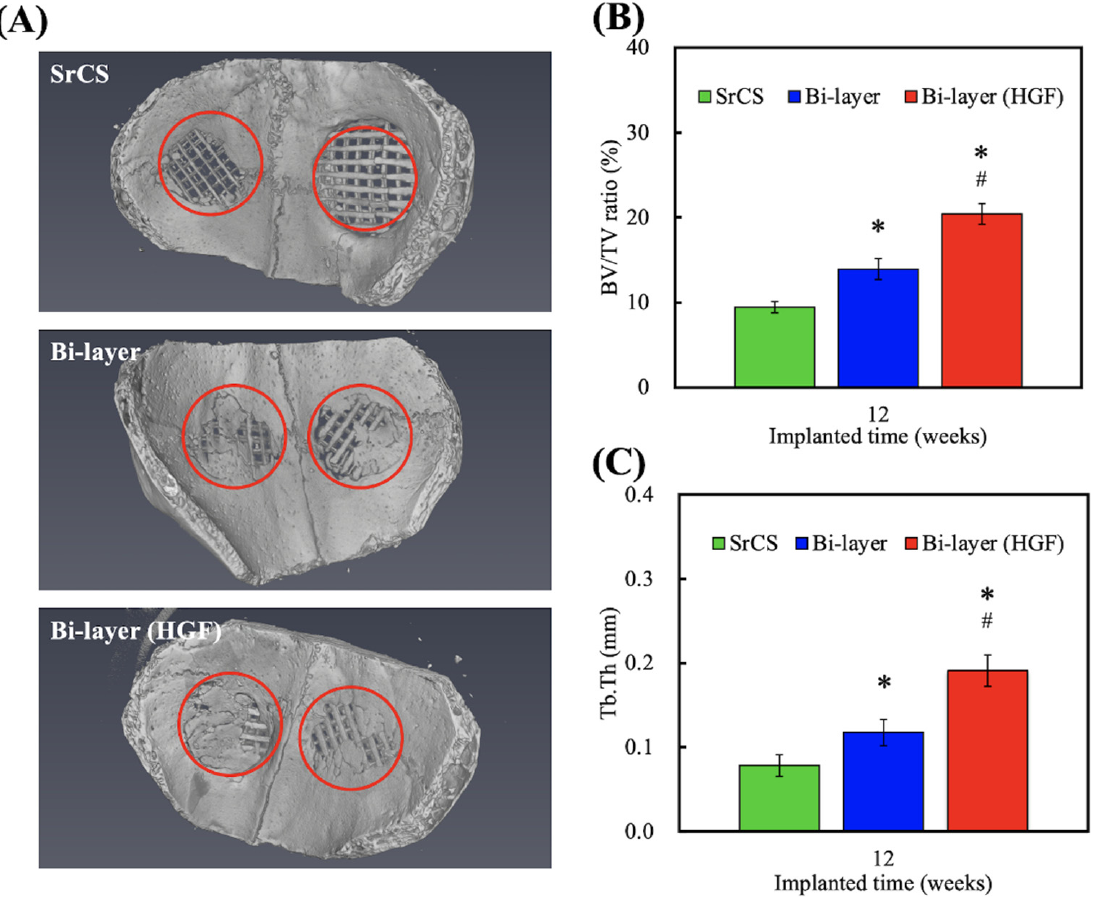
Figure 9. ( A ) Representative µ CT images of osteoporotic rabbits’ cranial bone defect model with different 3D-printed scaffolds after implanted for 12-weeks. The µ CT-quantified histograms of ( B ) bone volume/total volume (BV/TV) and ( C ) trabecular thickness (Tb.Th). * indicates a significant difference ( p < 0.05) when compared to SrCS. # indicates a significant difference ( p < 0.05) when compared to